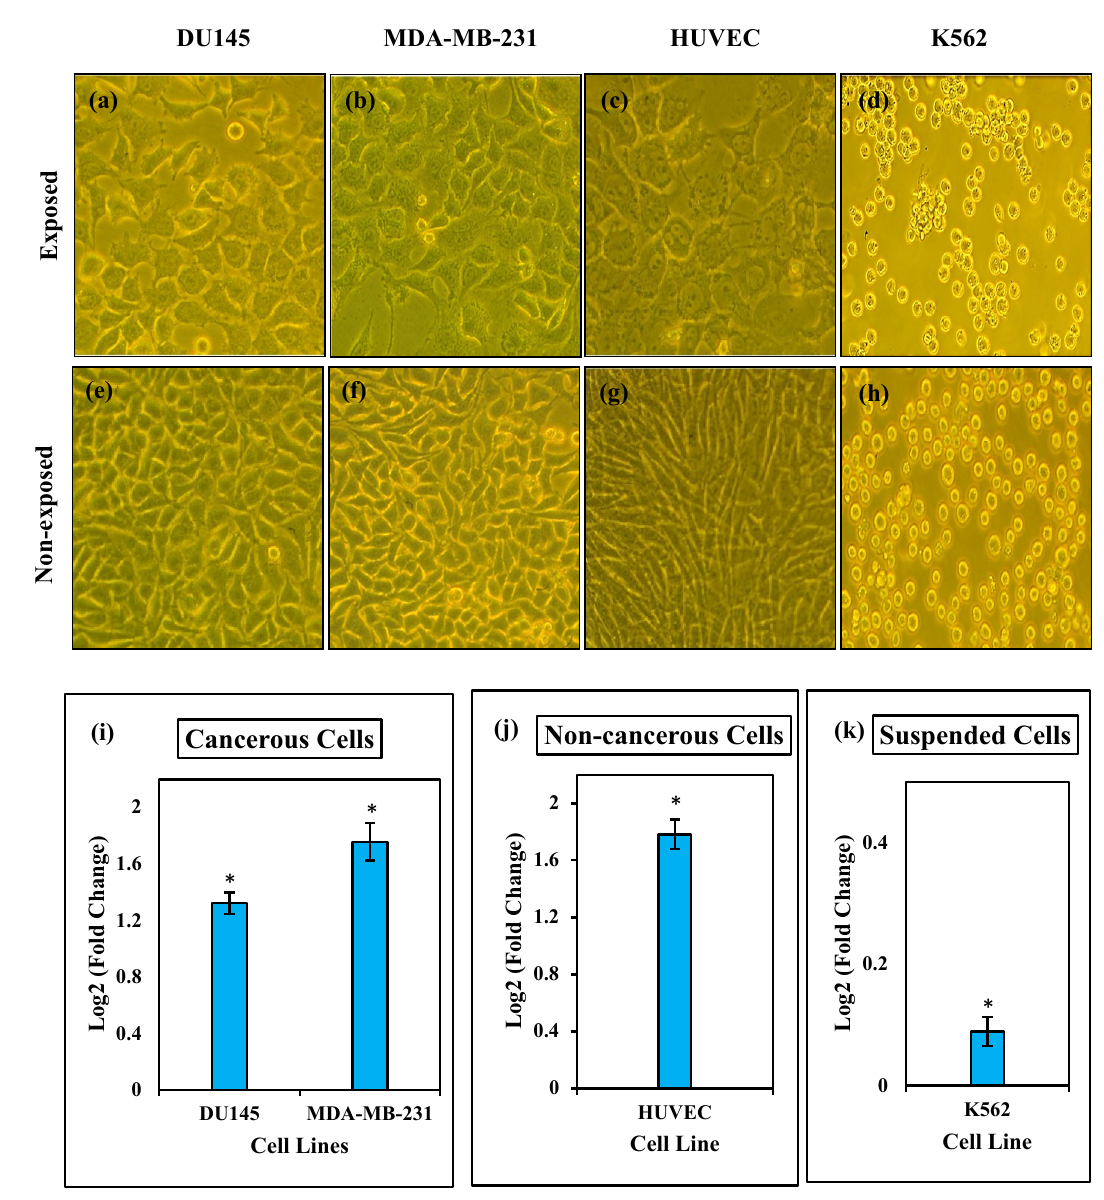
Figure 13. ELF-EMF can stimulate morphological changes. The representative images under an optical microscope (32X) show morphology changes in ( a ) DU145, ( b ) MDA-MB-231, ( c ) HUVEC, ( d ) K562 exposed to ELF-EMF with an intensity of 100 mT at 0.01 Hz for 120 h and MDA-MB-231 exposed to ELF-EMF with an intensity of 100 mT at 1 Hz for 120 h. Images show the morphology of ( e ) non-exposed DU145 cells, ( f ) non- exposed MDA-MB-231 cells, ( g ) non-exposed HUVEC cells, ( h ) non-exposed K562 cells. Histograms show quantified cell size changes following ELF-EMF exposure in ( i ) cancerous, ( j ) non-cancerous and ( k ) suspended cells. Bars indicate means ± SEM obtained from three or more independent experiments. Statistical significance between non-exposed and exposed groups was evaluated by a t-test. ( P -value < 0.05) was considered to indicate statistical